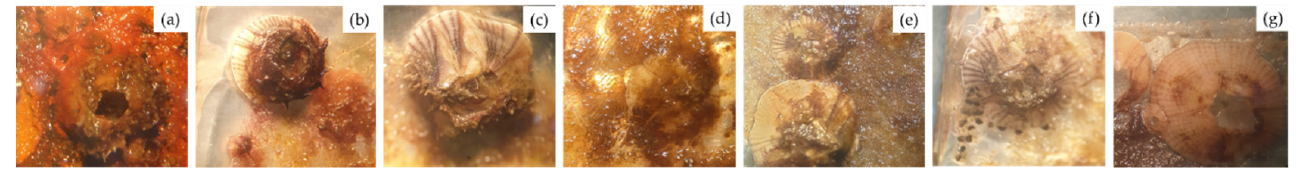
Figure 3. Digital microscope images of marine biofouling on various material surface in seawater ( a ) carbon steel; ( b ) neat PDMS; ( c ) PDMS with 1 wt.% SiO 2 ; ( d ) PDMS with 3 wt.% SiO 2 ; ( e ) PDMS with 5 wt.% SiO 2 ; ( f ) PDMS with 7 wt.% SiO 2 and ( g ) PDMS with 10 wt.% SiO 2 .